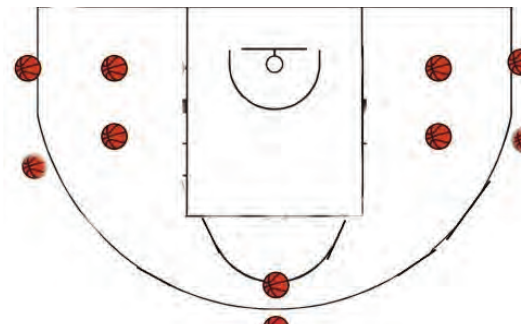
Fig. 2. Diagram of throws’ fulfillment from average and long